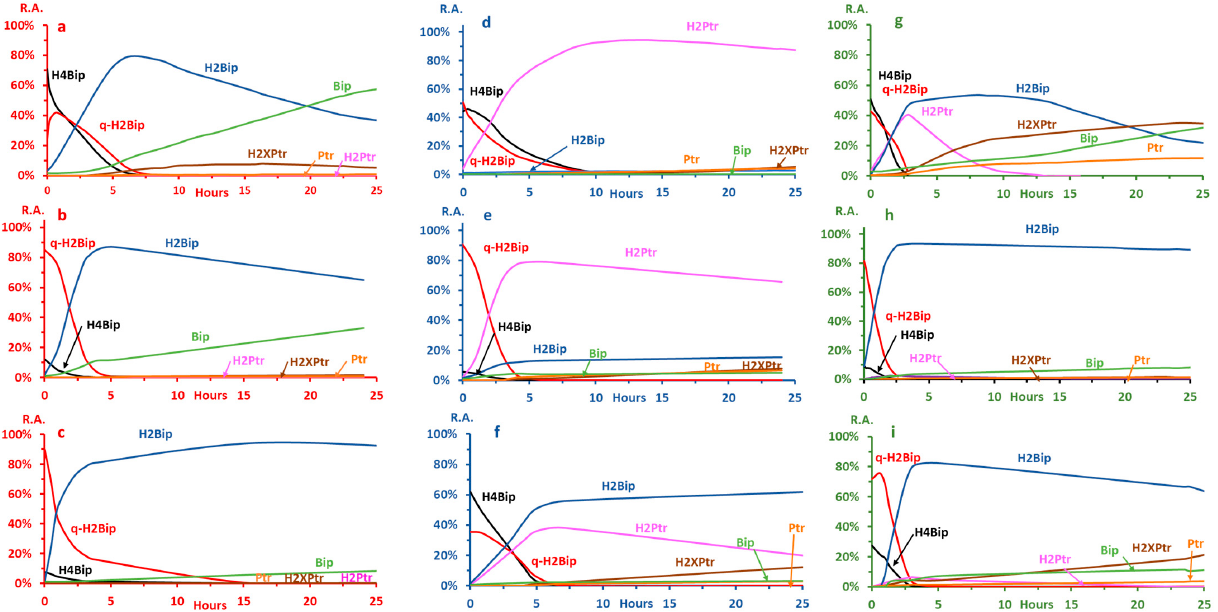
Figure 3. H4Bip autoxidation kinetics as a function of pH and type of buffer (0.1 M ammonium